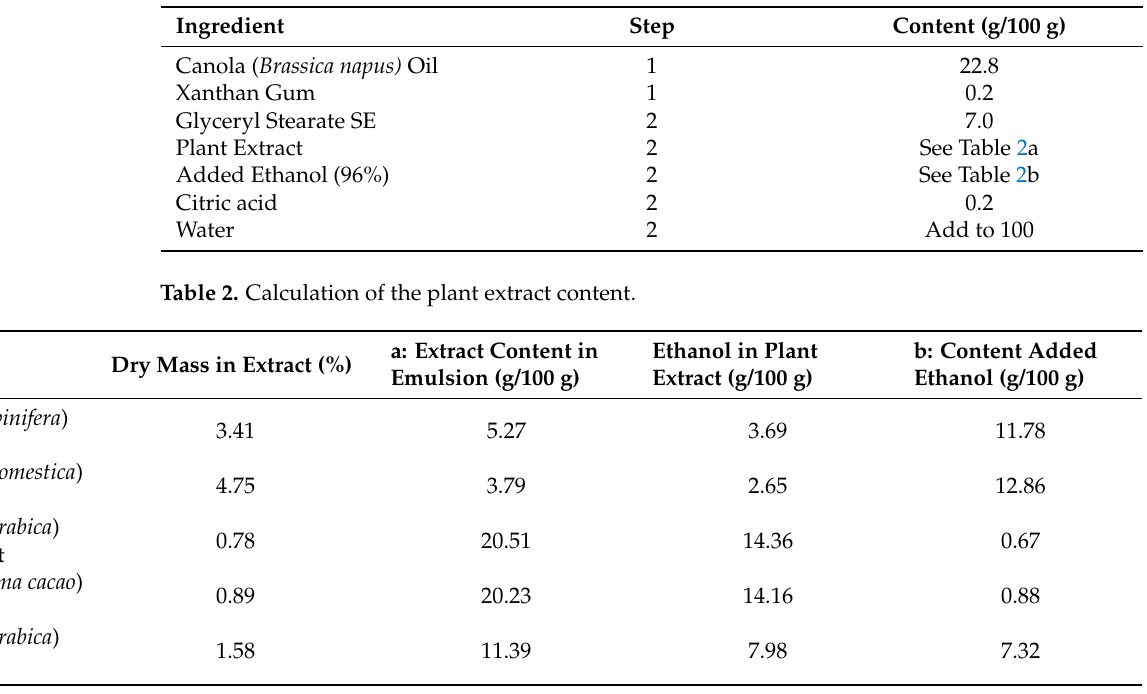
Table 1. Overview of the formulations used.